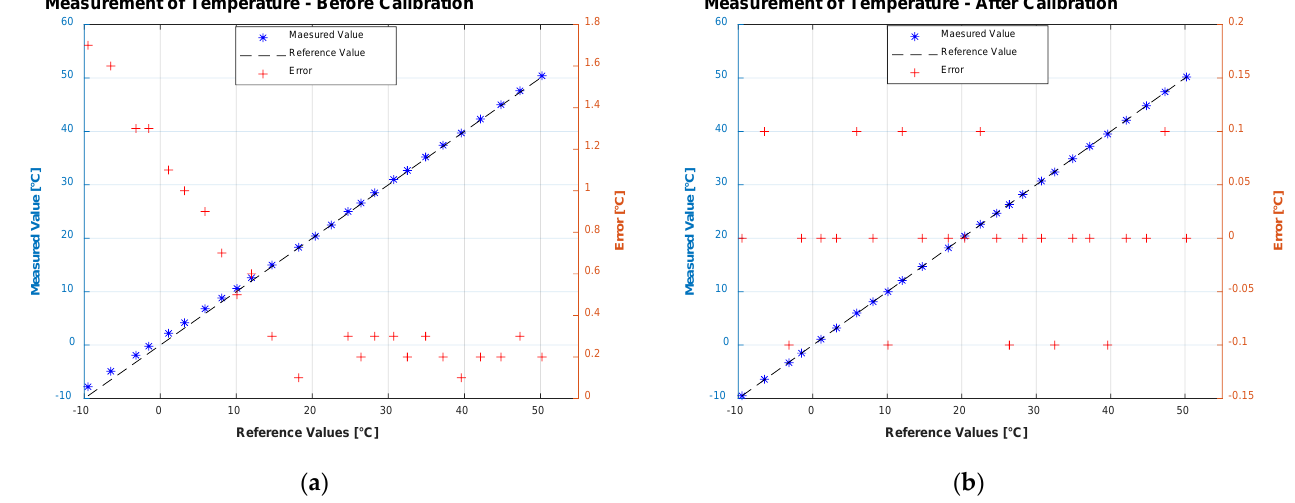
Figure 18. Measurement of Voltage: ( a ) Before Calibration; ( b ) After Calibration.